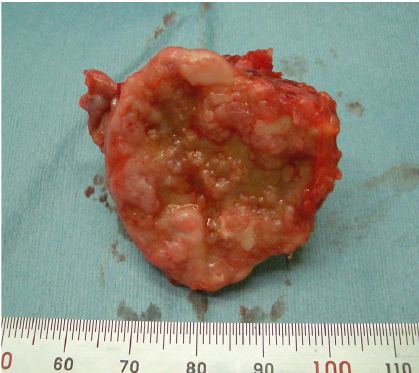
Figure 5: Macroscopic findings of the distal end of the osseous tumor. The distal surface was rather irregular. The typical thick perichondrium and cartilage cap were not found, although it was covered by spotty fibrocartilage-like